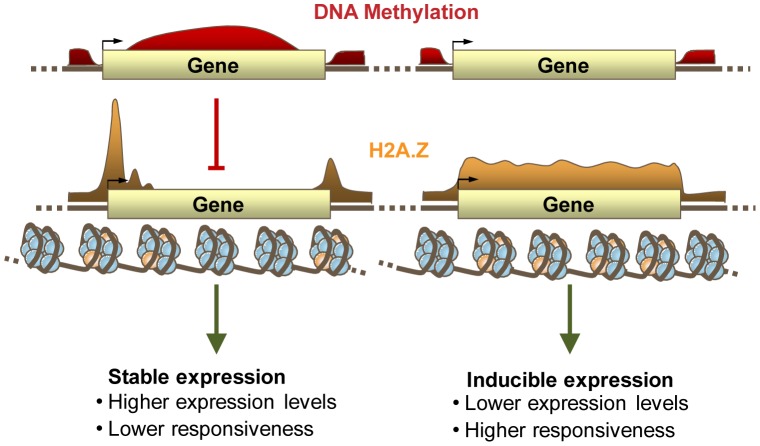
DNA Methylation, H2A.Z, and expression patterning.A proposed model for the relationship between DNA methylation (shown in red) and H2A.Z (shown in yellow) within genes, and their relationship with gene responsiveness and transcript level. Gene body methylation prevents the incorporation of H2A.Z within the bodies of highly and constitutively expressed genes. H2A.Z within unmethylated gene bodies regulates the expression of inducible genes.